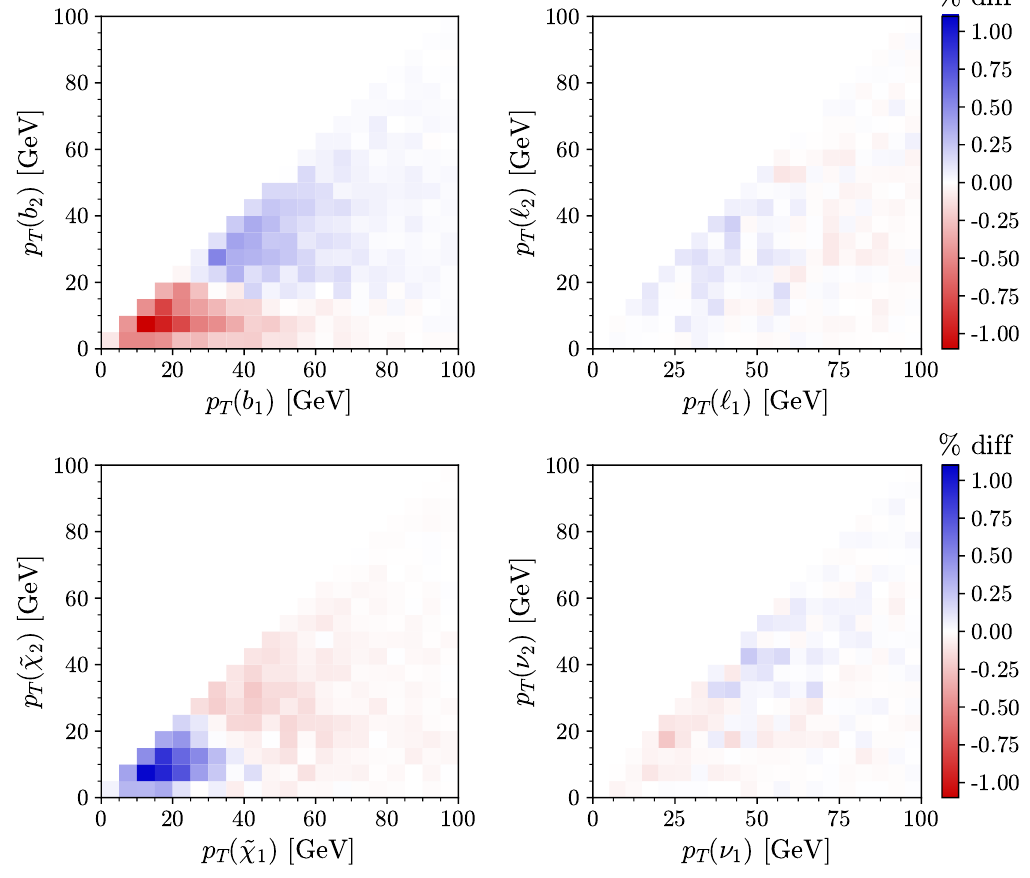
0 ) = 1 GeV 1 ) = 150 GeV and m (~ (cid:31) 1 , and the neutrino (cid:23) . The color 1